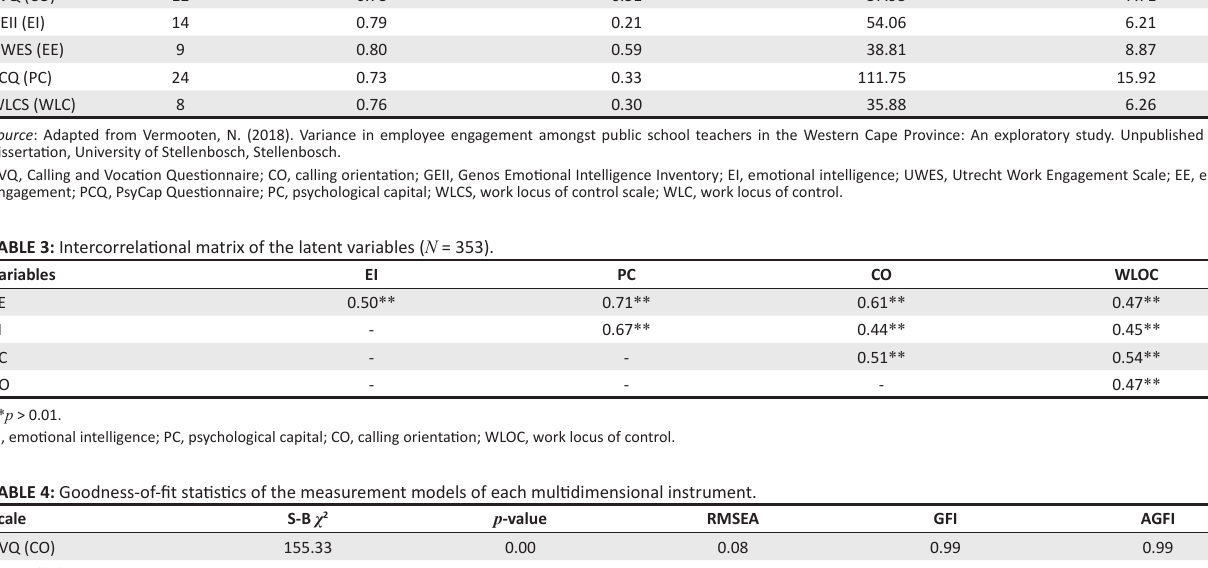
TABLE 2: Cronbach’s alpha, average inter-item correlation, mean and standard deviation of the measurement instruments.